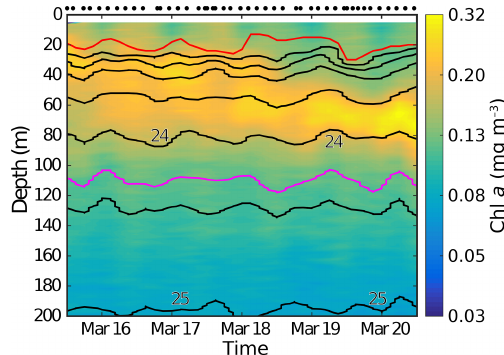
Figure 3. LDB CTD time series (in UTC) of chl a . Contours of density anomaly are superimposed in black ranging from 22 to 25kgm − 3 in increments of 0.5. MLD is shown in red, with D NO in magenta. Black circles above the panel indicate times of CTD